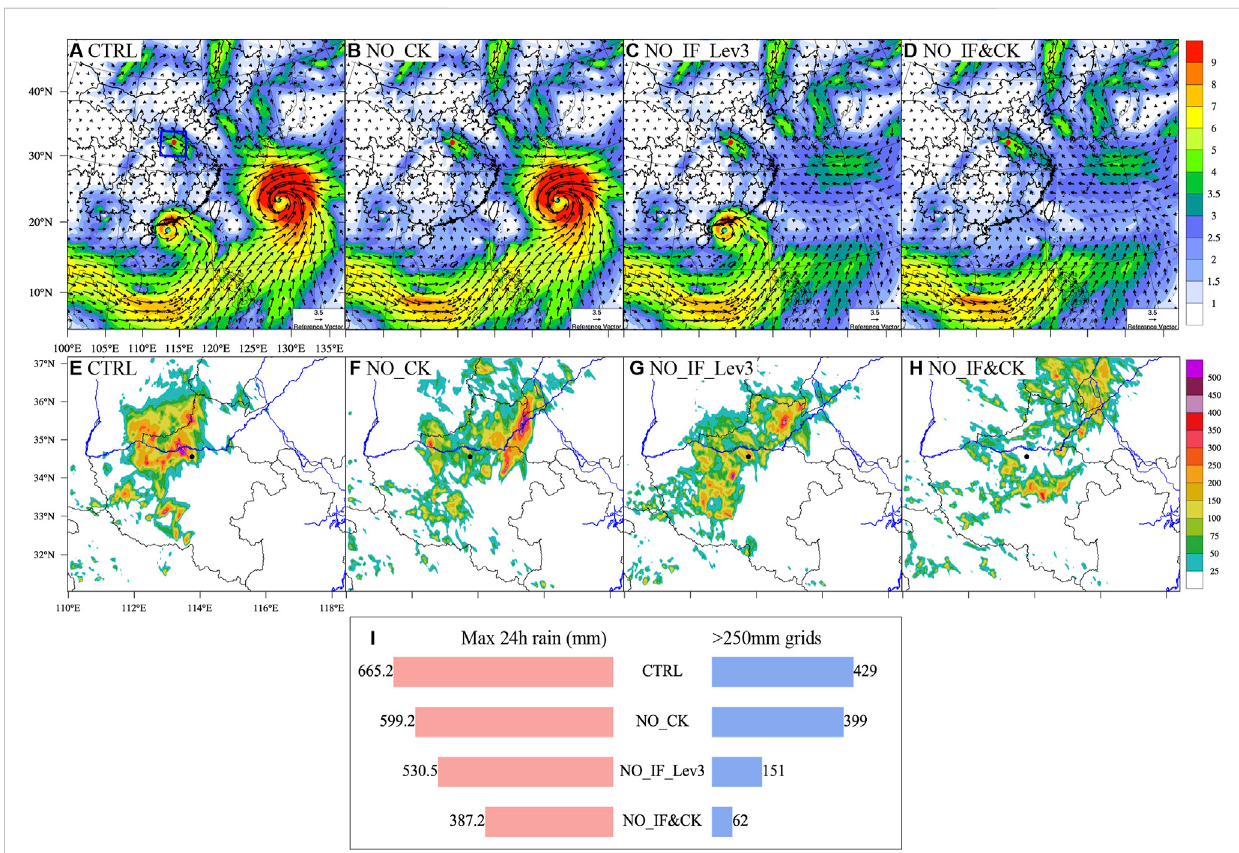
ComparisonofexperimentCTRL,NO_CK,NO_IF_Lev3,andNO_IF&CK. (A – D) Verticallyintegratedwatervapor fl ux(unit:10 2 kgm − 1 s − 1 )oftheinitial fi eld at 0000 UTC July 19. (E – H) 24 h precipitation (unit: mm) from 0000 UTC July 20 to 0000 UTC 21 July 2021. (I) Histograms of the maximum 24